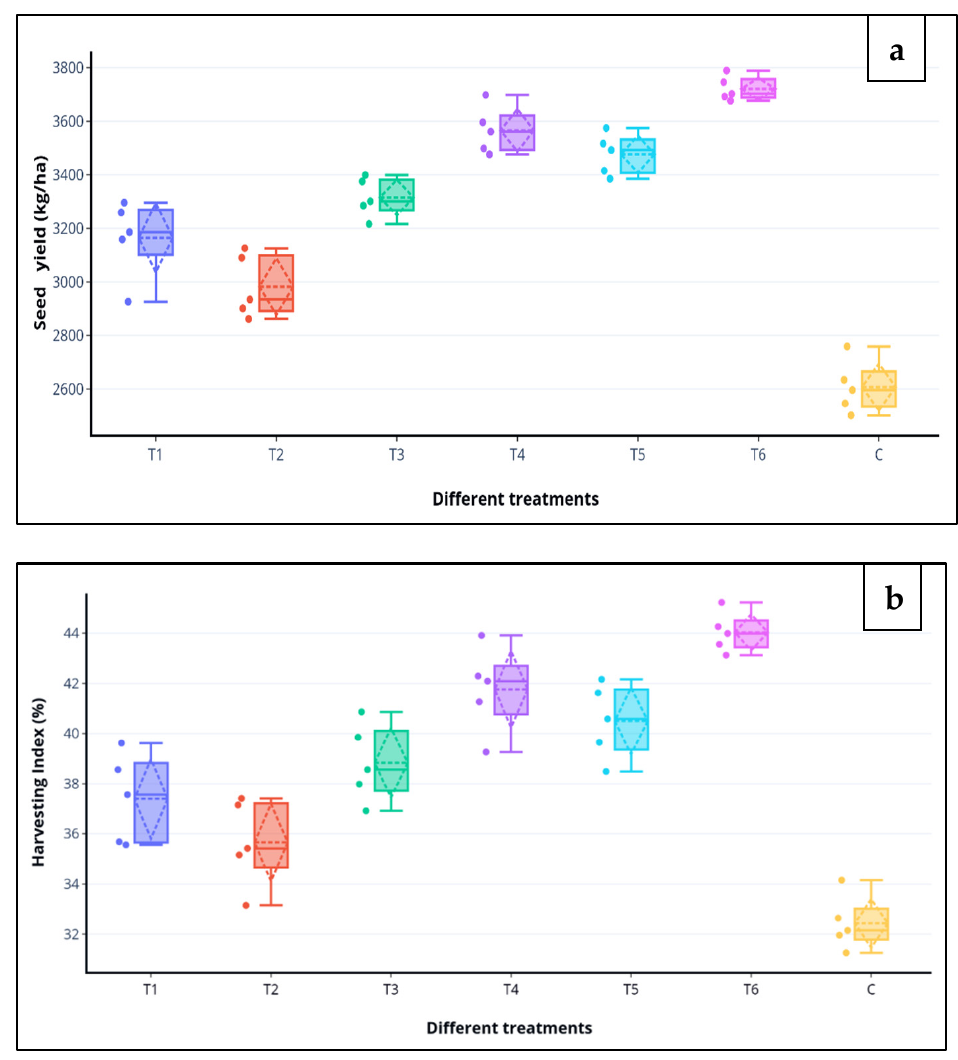
Figure 3. Effects of various treatments groups on the ( a ) seed yield (kg/ha) and ( b ) harvesting index (%) of chickpea in the field after 120 DAS. Boxplot representing five values of each treatment and showing the minimum value by the lower quartile (Q1—0.25), and the maximum value by the upper quartile (Q3—0.75). The horizontal line drawn in the middle denotes the median (Q2—0.50) and scattered lines show the standard